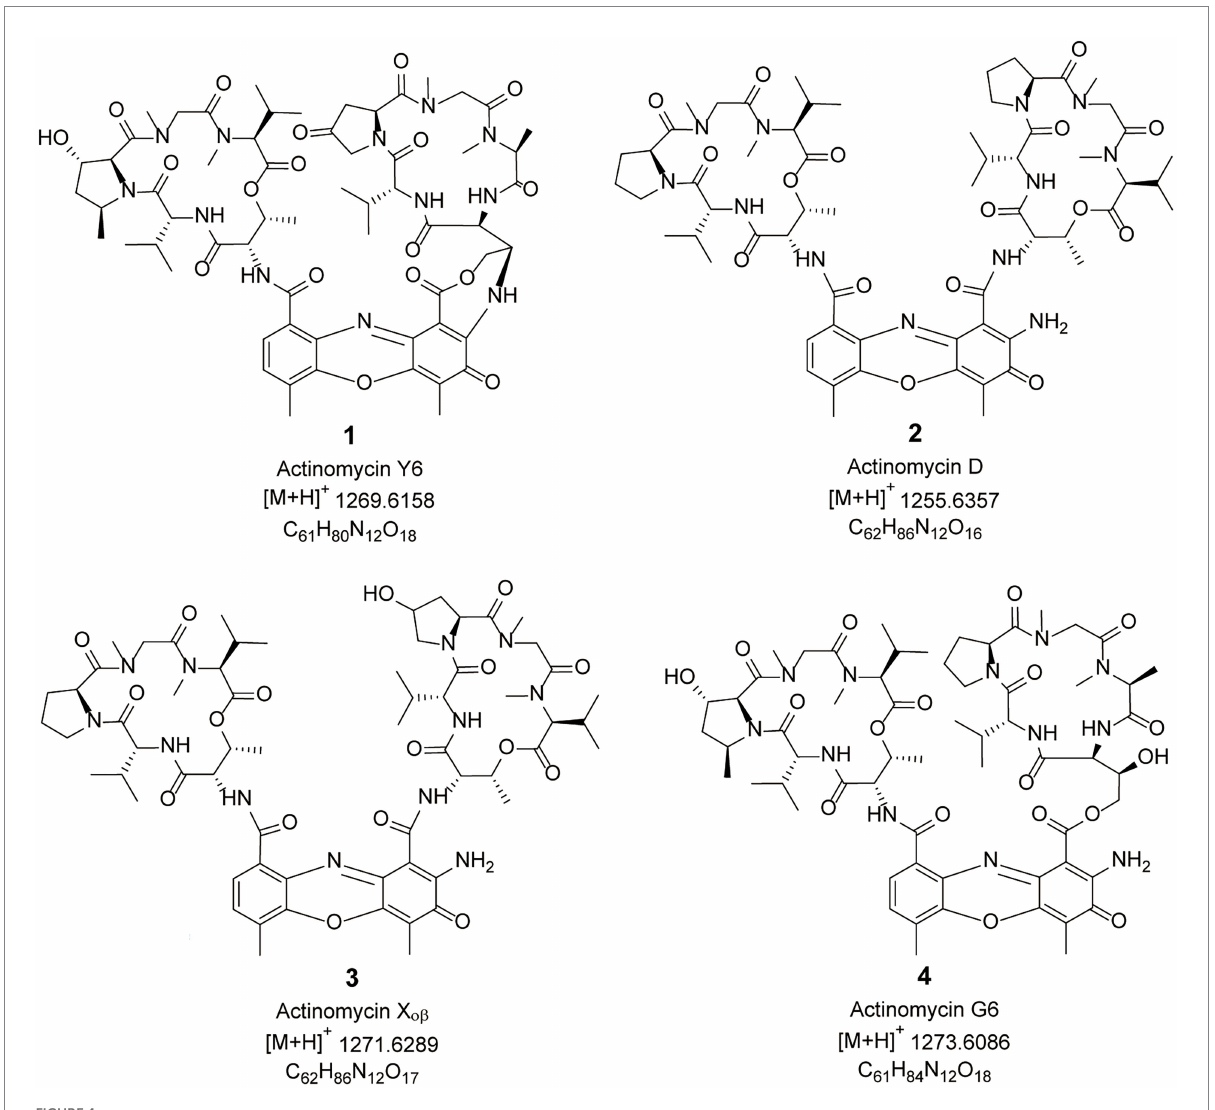
FIGURE 4 Chemical structures of compounds 1 – 4